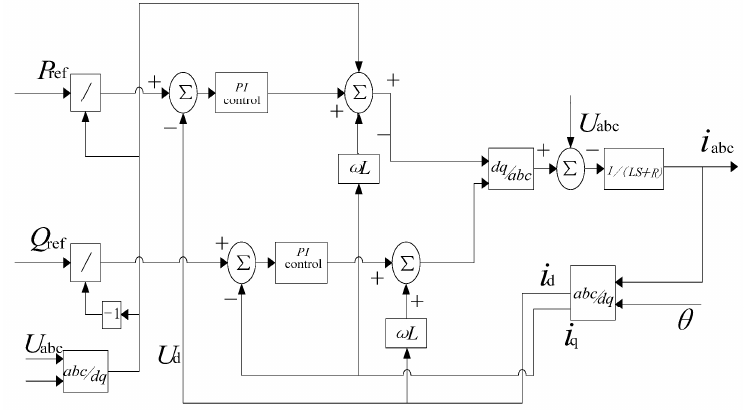
Figure 11. Inverter constant power (PQ) control system structure.